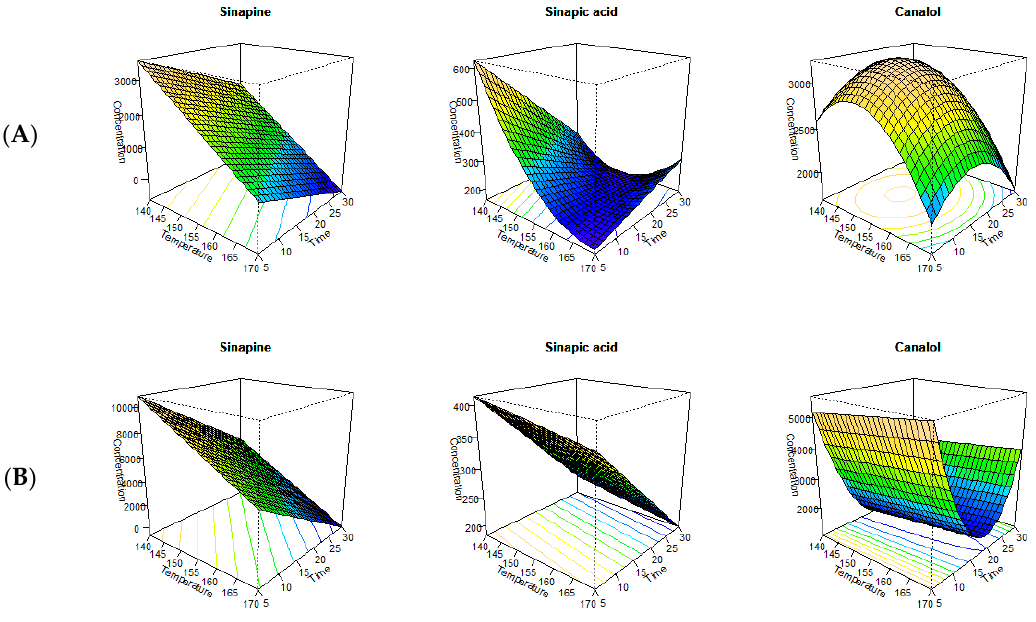
Figure 1. Response surface analysis of the major sinapates (( A )—methanol, ( B )—ethanol).